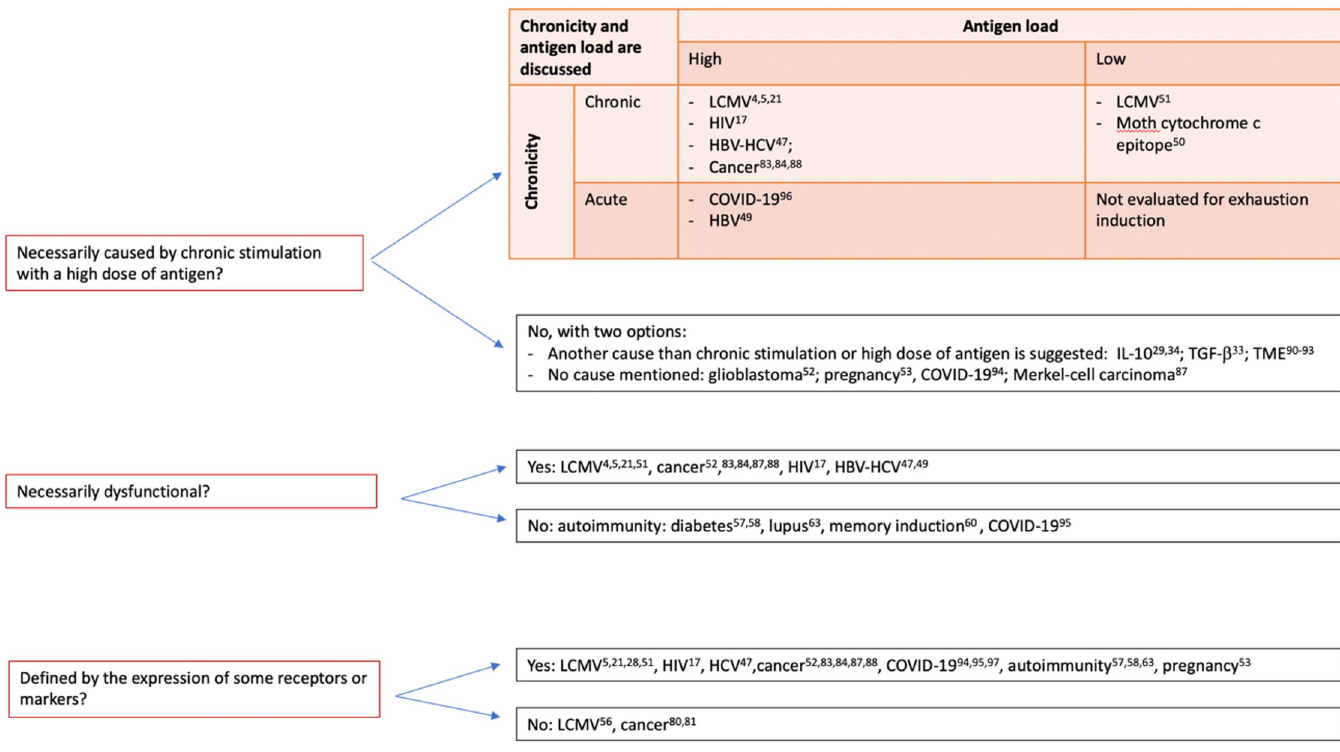
Fig 2. Key controversies about immunological “exhaustion”. C AU : AbbreviationlistshavebeencompiledforthoseusedthroughoutFigs 2 (cid:0) 4 : Pleaseverifythatallentriesarecorrect : OVID-19, Coronavirus Disease 2019; HBV, hepatitis B virus; HCV, hepatitis C virus; IL, interleukin; LCMV, lymphocytic choriomeningitis virus; TGF- β , transforming growth factor beta; AU : Pleasedefine } TME } intheabbreviationlistofFig 2 ifapplicable = appropriate : Tumor Micro Environment (TME), xxx.